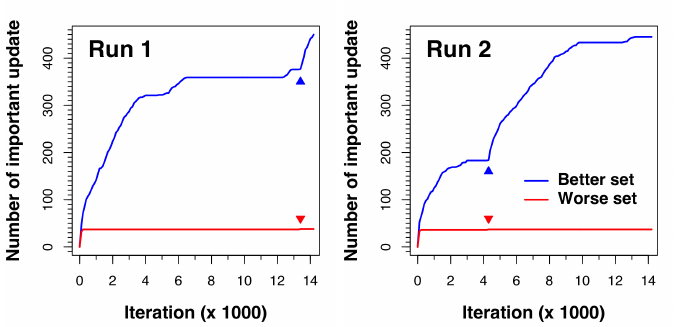
Figure 4. Number of updates that occurred in the better and worse sets in two docking runs of the representative complex 1a30. The colored triangles indicate the an iteration where an important worse set update (red) leads to subsequent rapid updates of the better set (blue).